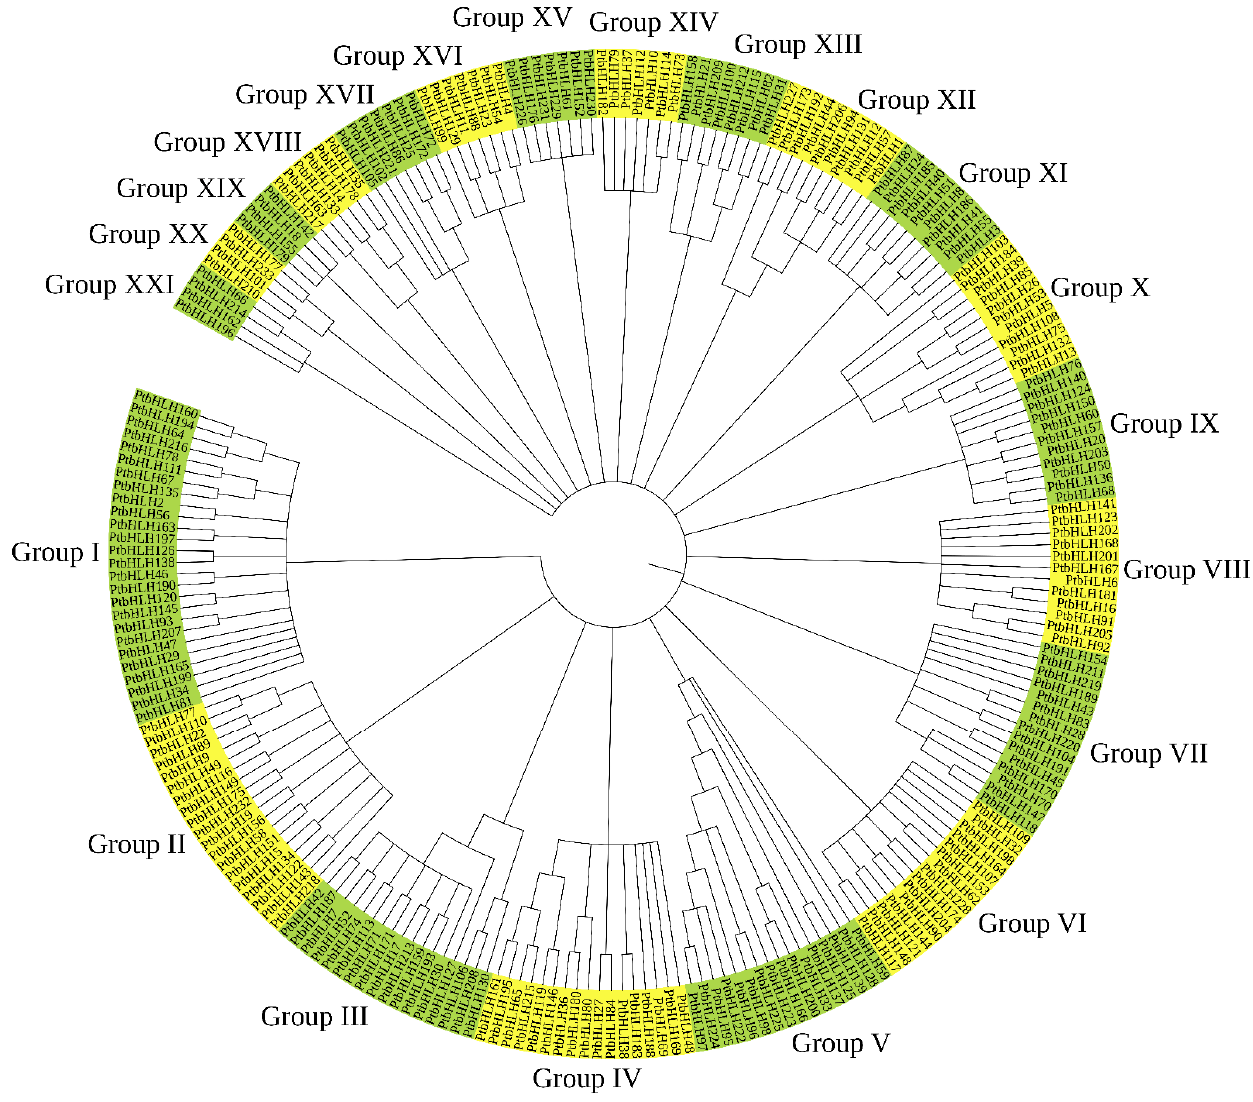
Figure 3. Phylogenetic tree based on protein sequences of bHLH gene family in poplar. The phylogenetic tree was constructed using the neighbor-joining (NJ) method, with 1000 bootstrap replicates, using Mega-X.